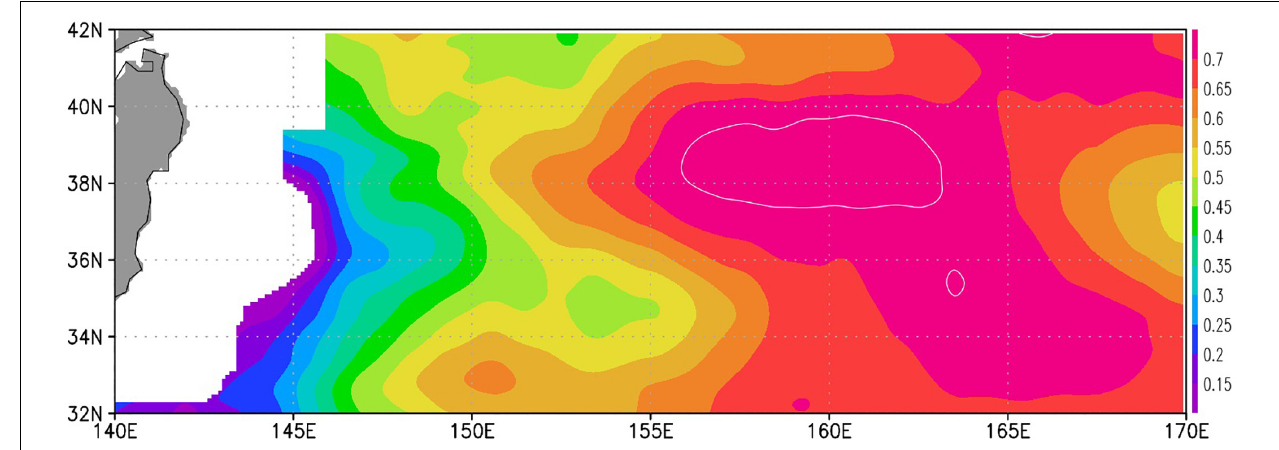
FIGURE 9 | Horizontal map of the square root of the potential predictability (PP) of the simulated 5 ◦ –longitude and 5 ◦ –latitude averaged EKE. The value is plotted at the grid point of the center of the 55 ◦ –longitude and 5 ◦ –latitude area. White contours indicate 0.75. A 13-month running-mean is applied to and the linear trend is removed from EKE before estimating